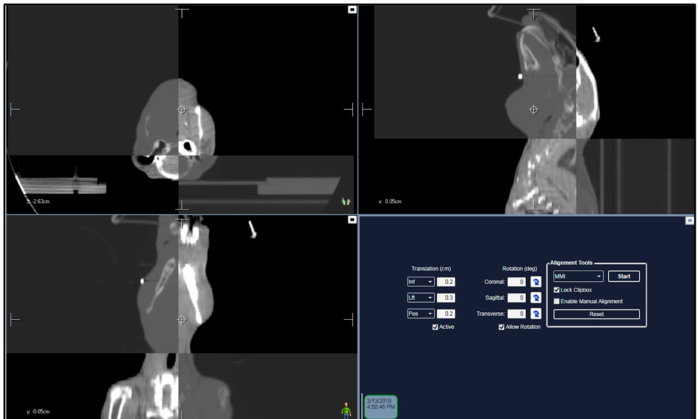
Figure 3. Co-registration of CBCT and treatment planning CT. Panel of images show axial, sagittal, and coronal sections of cone beam CT images aligned with treatment planning CT for verification prior to radiation delivery. Any shifts in position were calculated and applied onto the treatment couch to ensure accurate targeting of the